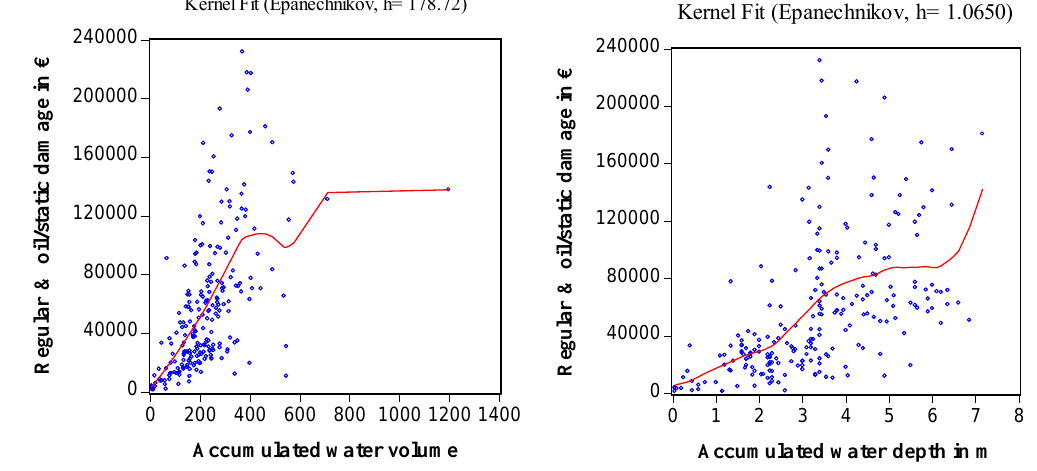
Fig. 3. Scatter plot with the water-volume- and water-depth-damage function (Epanechnikov-kernel with bandwidth h) for all damage (regular as well as oil/static damage). Data source: Amt der N ¨O Landesregierung, Abteilung Landwirtschaftsf¨orderungen (2006a). analyses, to which we turn now, however, is estimation of in- dividual coefficients of the water depth/volume in the cellar, ground floor and the adjoining buildings in a disaggregated